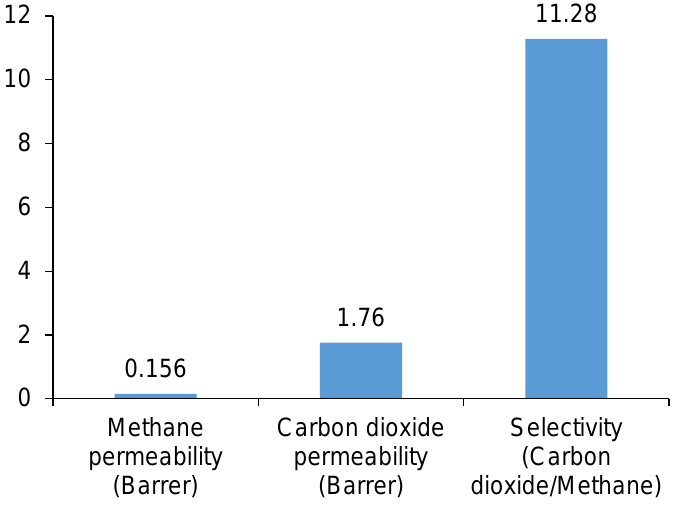
Figure 10. Permeation traits of CO 2 and CH 4 across fresh polyimide membrane.